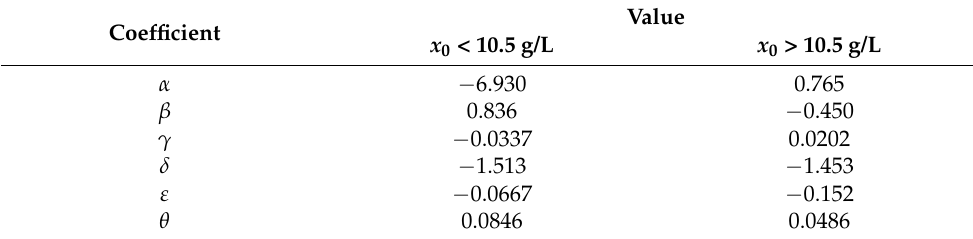
Table 2. Tuned coefficients for Equation